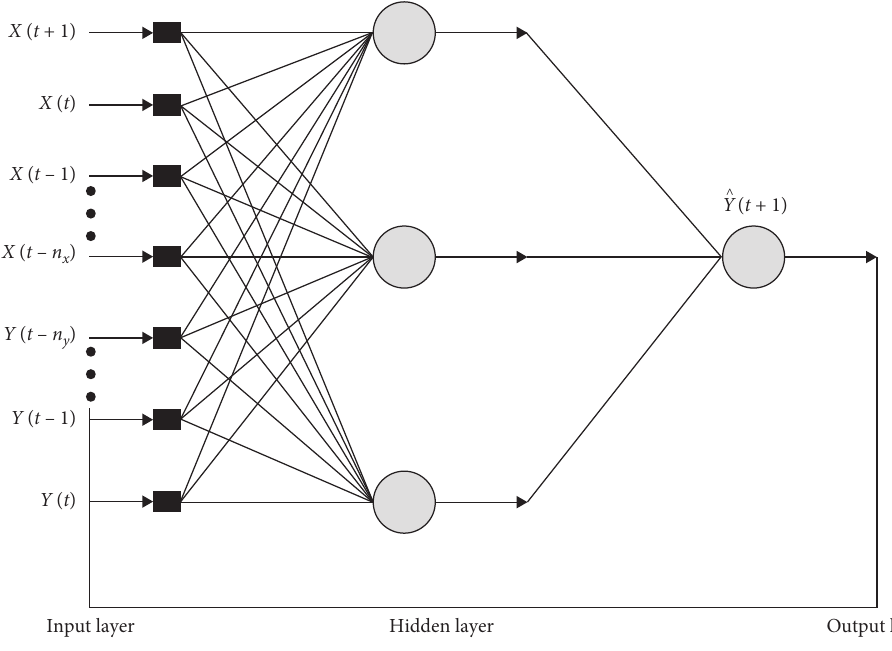
Figure 3: Scheme of NARX